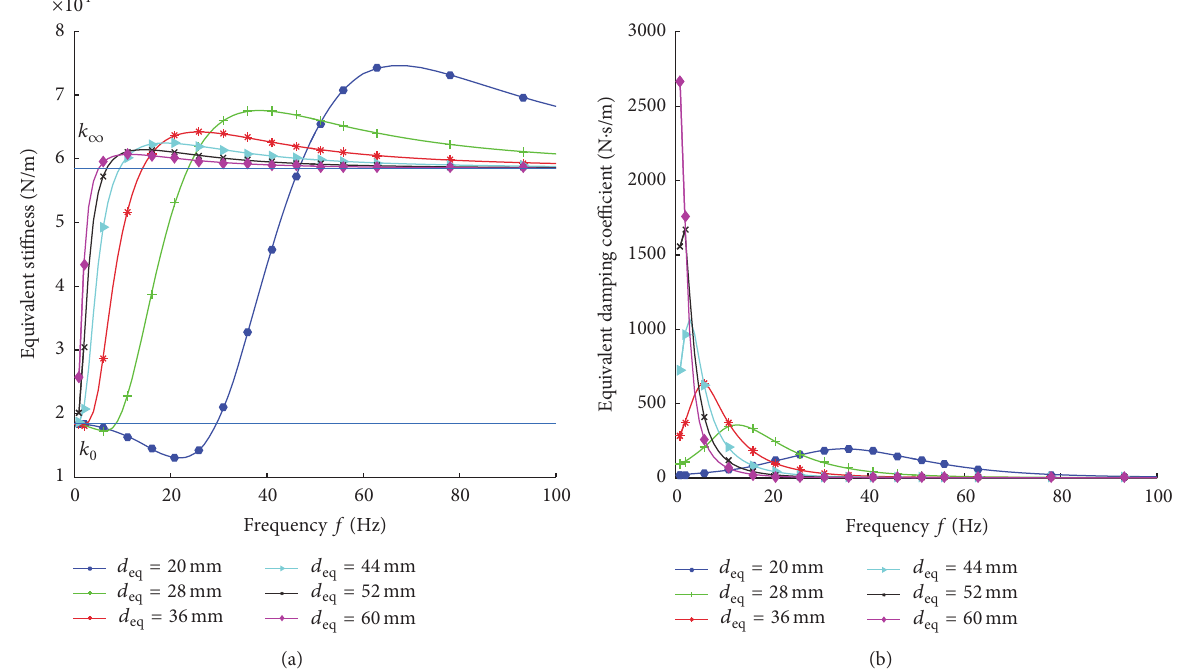
Figure 10: (a) Equivalent stiffness under different 𝑑